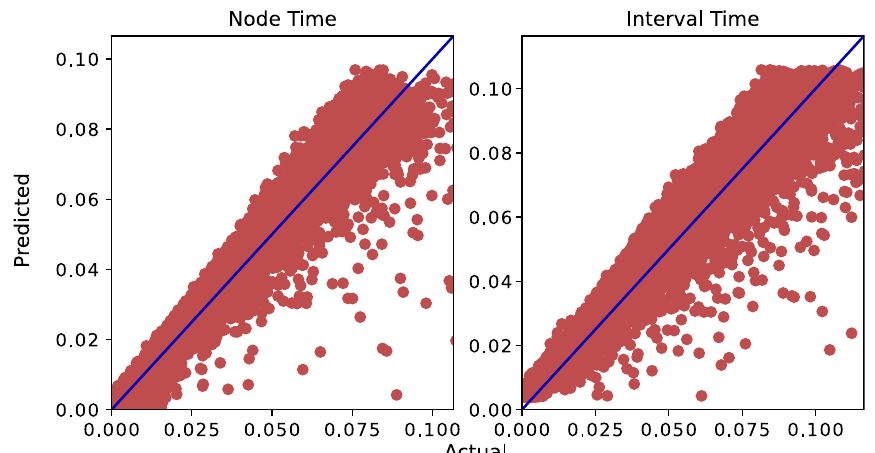
Fig. 9 Predicted vs. actual node-based (using adjacency dictionary) and time-based (using interval tree) slice times for 5,000 compound slices on the Infectious data set. The blue line illustrates the line y = x , denoting perfect predictions. Our dual linear regression model predicts both node-based and time-based slice times with reasonable accuracy